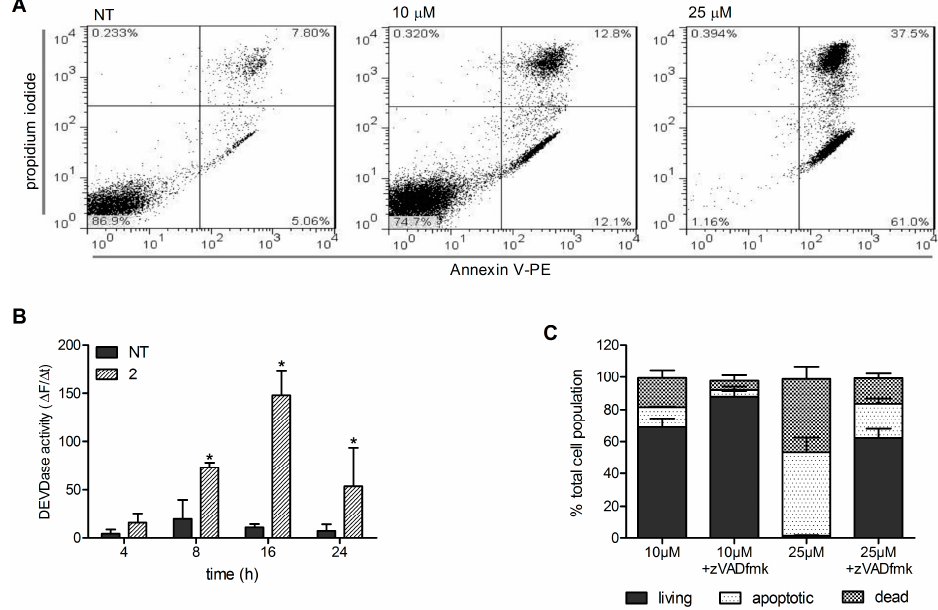
Figure 3. ( A ) Determination of annexin-V-positive and propidium-iodide-positive Ramos cells after treatment with vehicle (NT) and 10 µM and 25 µM Compound 2 (as indicated) for 24 h, with analysis by flow cytometry. The data are representative of a single experiment, of three independent experiments; ( B ) Ramos cells were treated for 4, 8, 16, and 24 h with vehicle (NT) and 25 µM Compound 2 . Caspase 3/7 activity was determined spectrofluorometrically by measuring cleavage of Ac-DEVD.AFC in whole-cell lysates. The data are changes in fluorescence with time, as means (±SD) from three independent experiments, each conducted in triplicate. * , p < 0.05, versus relevant vehicle control; ( C ) Analysis of annexin-V/propidium-iodide–positive cells after 24 h treatment with 10 µM and 25 µM Compound 2 in the absence and presence of 50 µM zVADfmk. The data are means (±SD) from three independent experiments, each conducted in